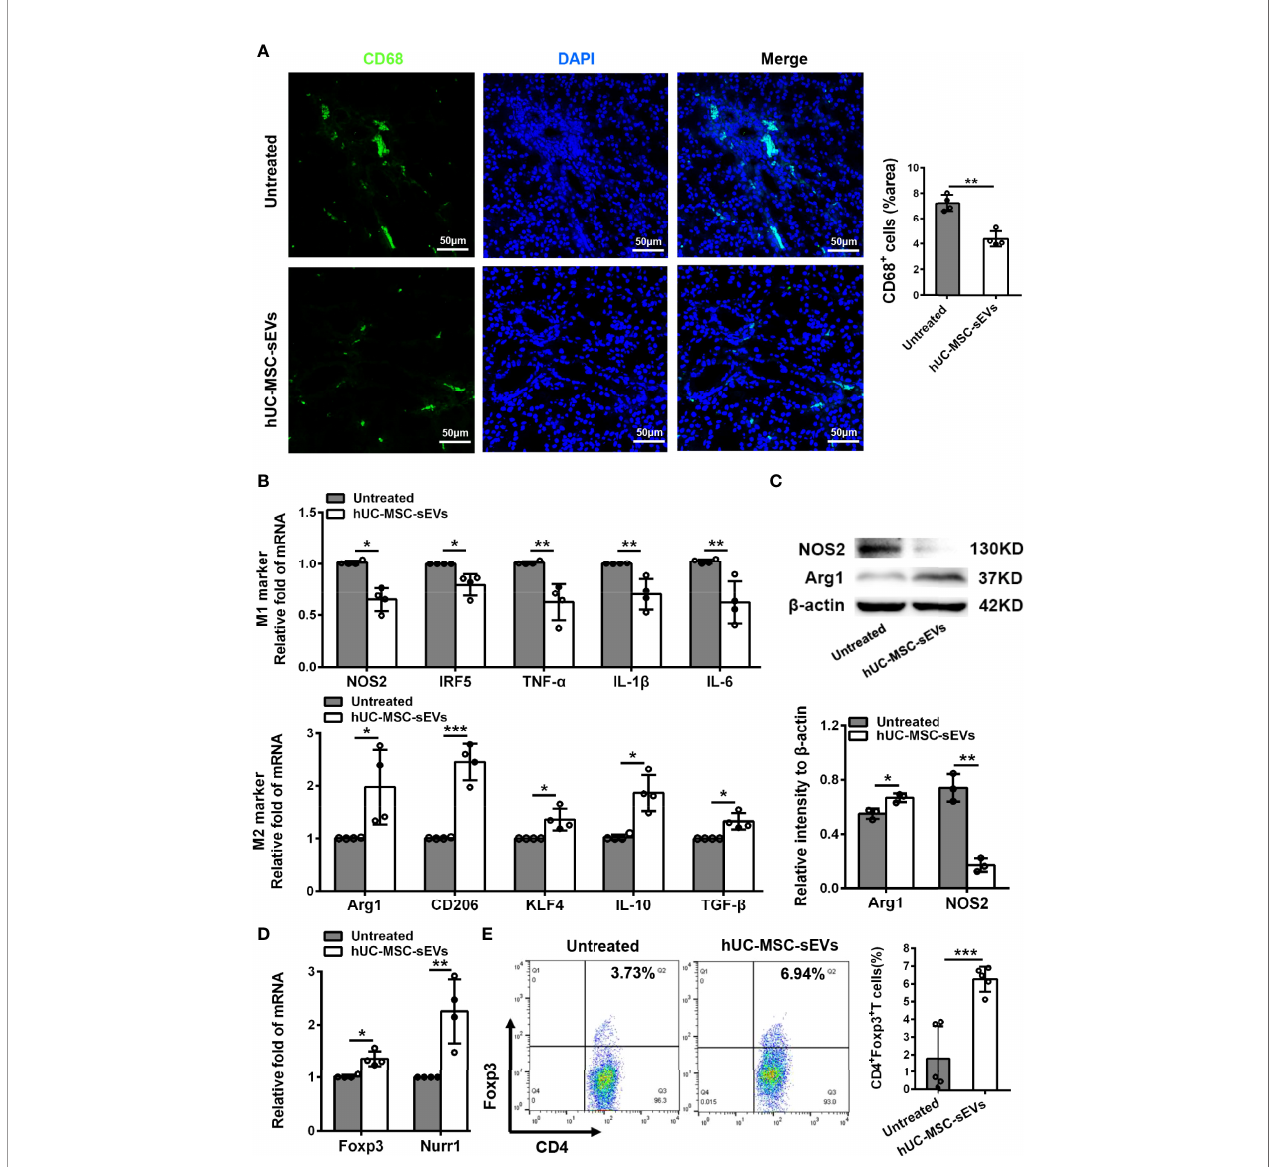
FIGURE 3 | hUC-MSC-sEVs administration promoted M2 macrophage polarization and induced Treg generation in vivo . LGs were collected from rabbits in the untreated and hUC-MSC-sEVs group at week 8. (A) Representative immuno fl uorescent histological images of CD68 (pan macrophage marker) expression in LGs, and quanti fi cation of percent area of CD68+ cells. (B) Gene expression of M1 macrophage markers (NOS2, IRF5, TNF- a , IL-1 b and IL-6) and M2 macrophage markers (Arg1, CD206, KLF4, IL-10 and TGF- b ) in LGs. (C) Representative western blot images and quanti fi cation of relative band intensities for NOS2 and Arg1 in LGs. (D) Gene expression of Foxp3 and Nurr1 in LGs. (E) Flow cytometric analysis of the percentage of CD4+Foxp3+T cells among lymphocytes isolated from LGs. Representative data from at least three independent experiments were presented as mean± SD. *P < 0.05, **P < 0.01, ***P <